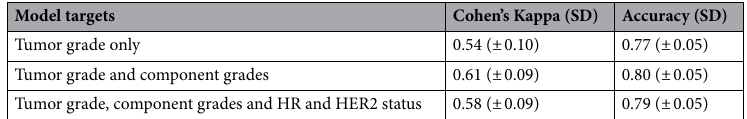
Table 2. Agreement and accuracy of model versus pathologist grading of no special type (NST) tumors. The results for three models trained on different sets of targets are shown on the validation set ( n = 142). The standard deviation (SD) was calculated using bootstrapping. HR hormone receptor.